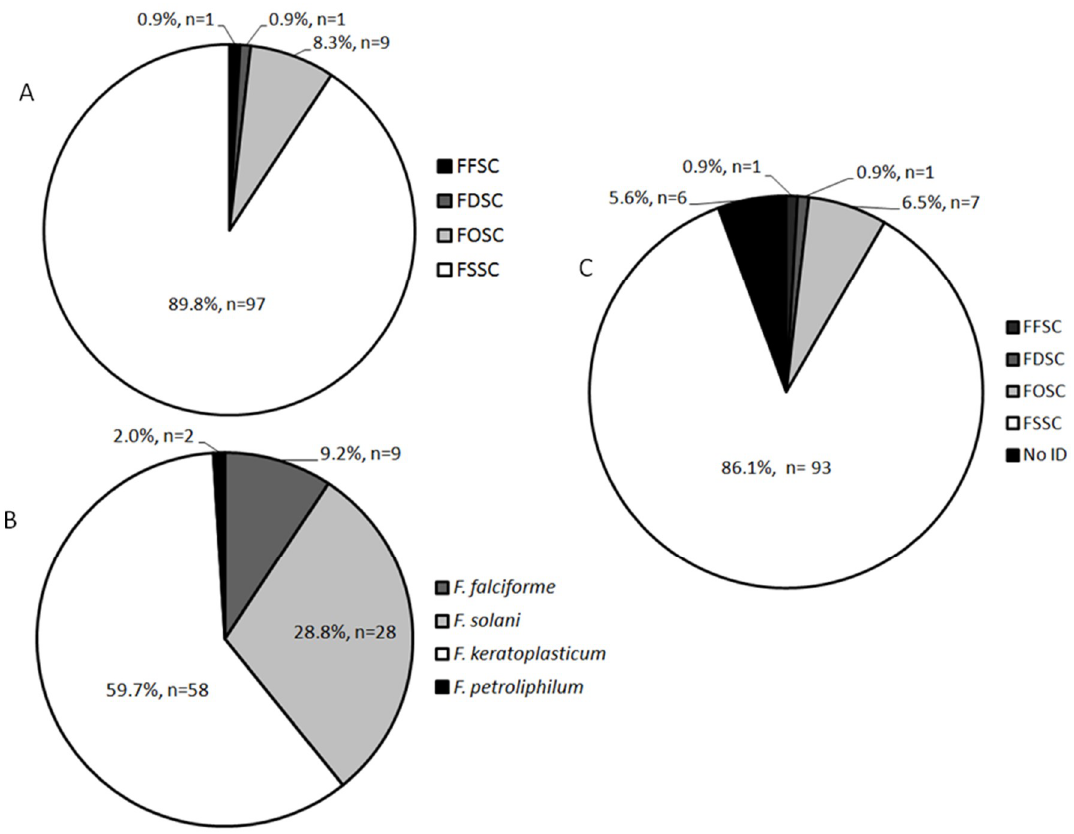
Figure 1. Graphical summary of molecular (ITS and EF-1α) and matrix-assisted laser desorption/ionization time-of-flight mass spectrometry (MALDI-TOF MS) identification of Fusarium species complexes clinical isolates ( n = 108). ( A ) ITS sequencing identification. ( B ) Fusarium species of FSSC (sequencing of EF-1 α ). ( C ) MALDI-TOF MS identification. FSSC: Fusarium solani species complex; FOSC: F. oxysporum species complex; FFSC: F. fujikuroi species complex; FDSC: F. dimerum species complex.